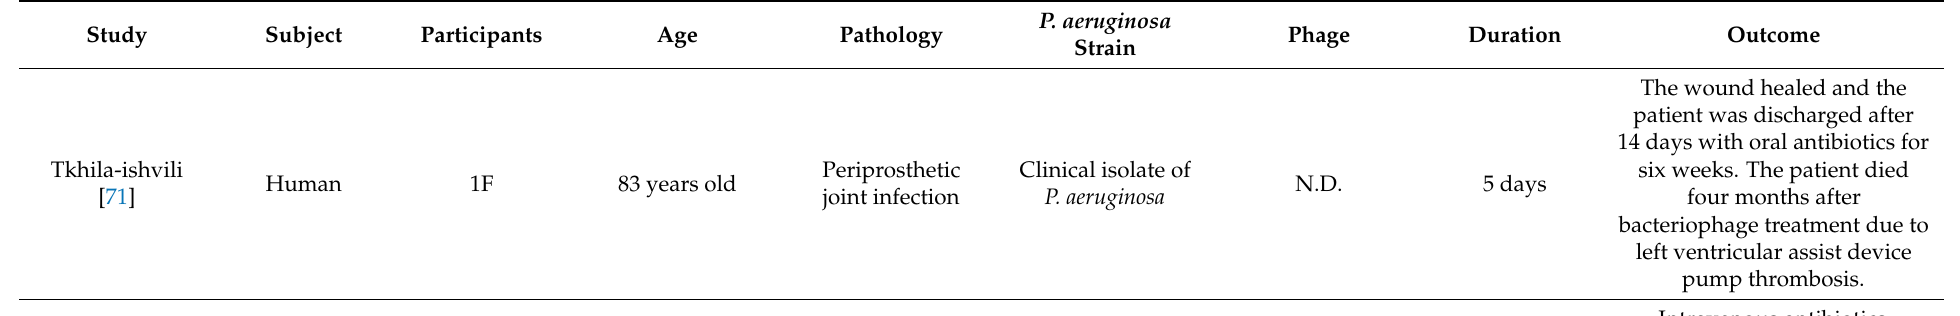
Table 5. Clinical studies about phage therapy for Pseudomonas aeruginosa